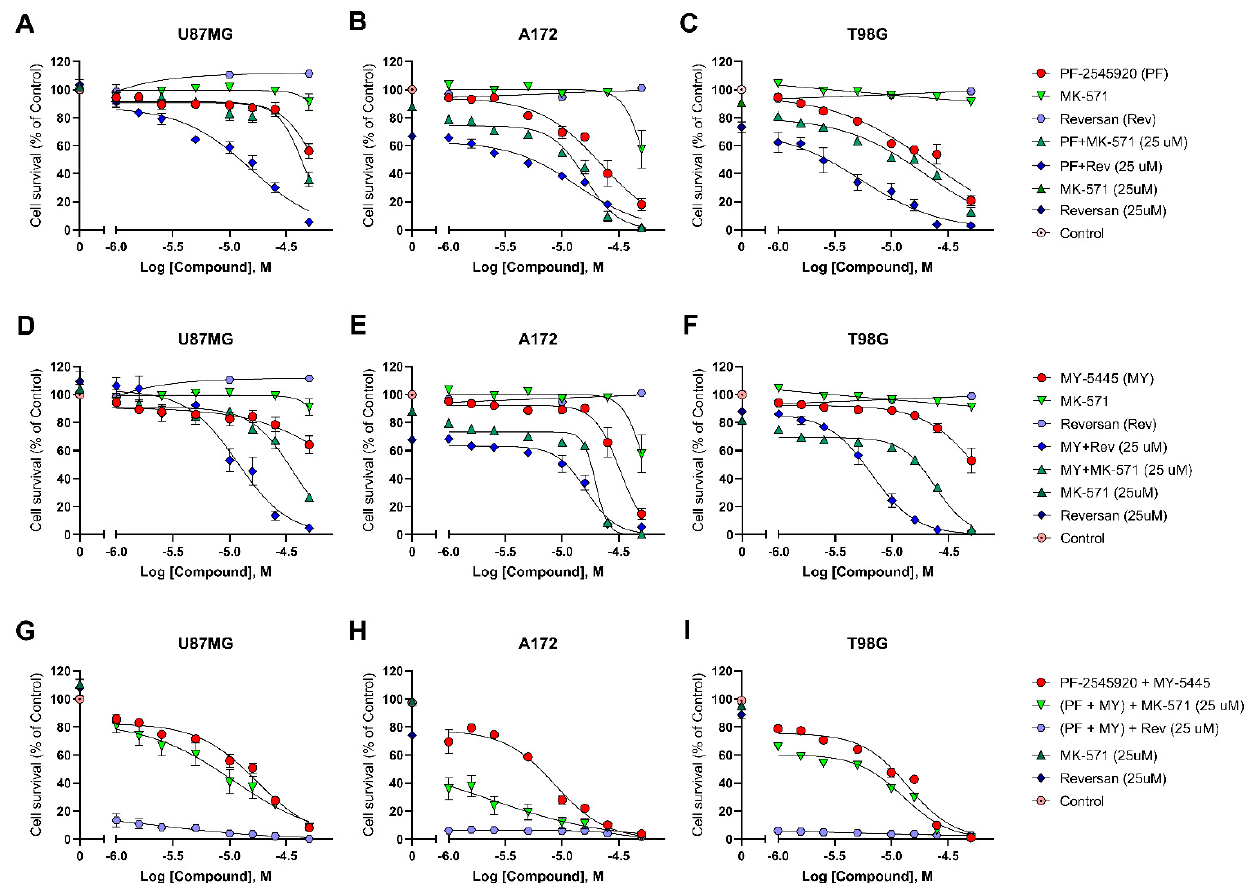
Figure 6. Potentiation of the antiproliferative action of PF-2545920 and MY-5445 in glioblastoma cells by the co-treatment with MRP1 inhibitors. Concentration–response relationships for the inhibitory action of PDE inhibitors PF-2545920 ( A – C ) and MY-5445 ( D – F ) on glioblastoma cell survival were obtained using the CCK-8 assay in the absence or presence of the MRP1 inhibitors MK-571 and reversan. Maximal antiproliferation effects were observed when either MK-571 or reversan was co-applied with both PDE inhibitors ( G – I ). Data are presented as the mean ± standard error of the mean ( n = 6–12).